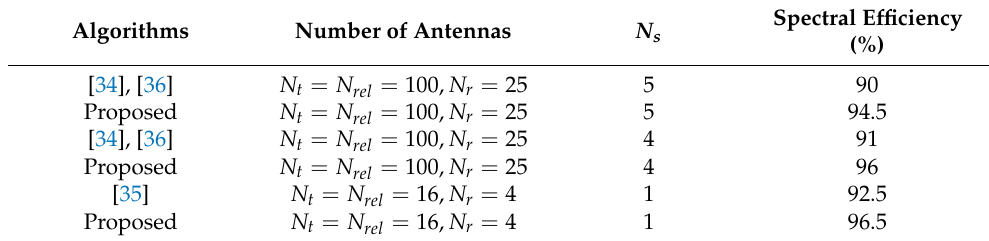
Table 2. Performance comparison with other